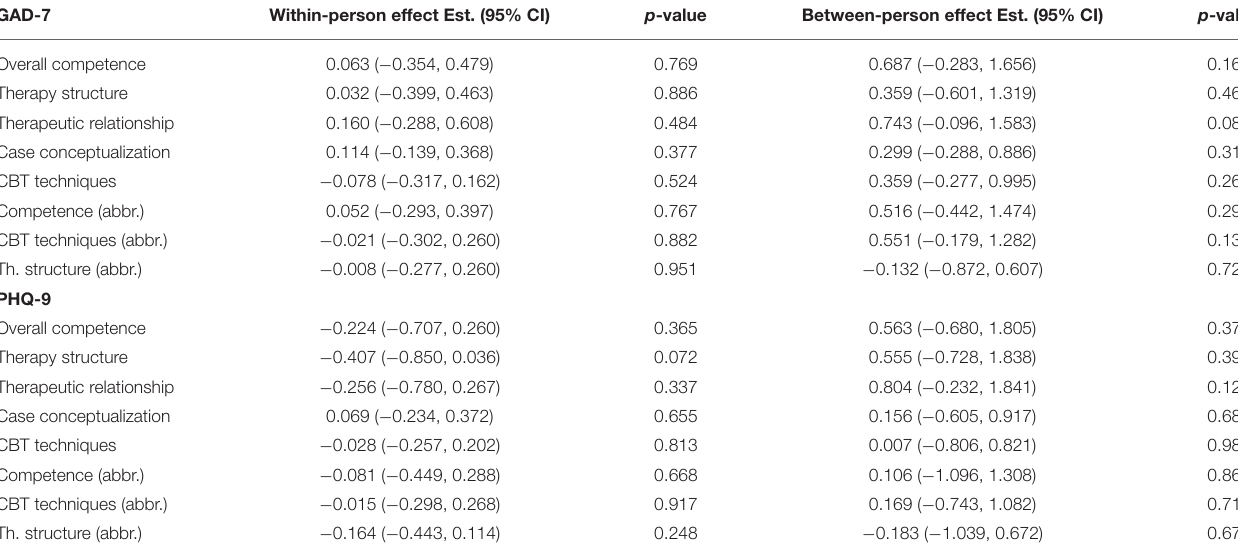
TABLE 4 | Multilevel associations between CTACS and treatment outcomes in PMHC.